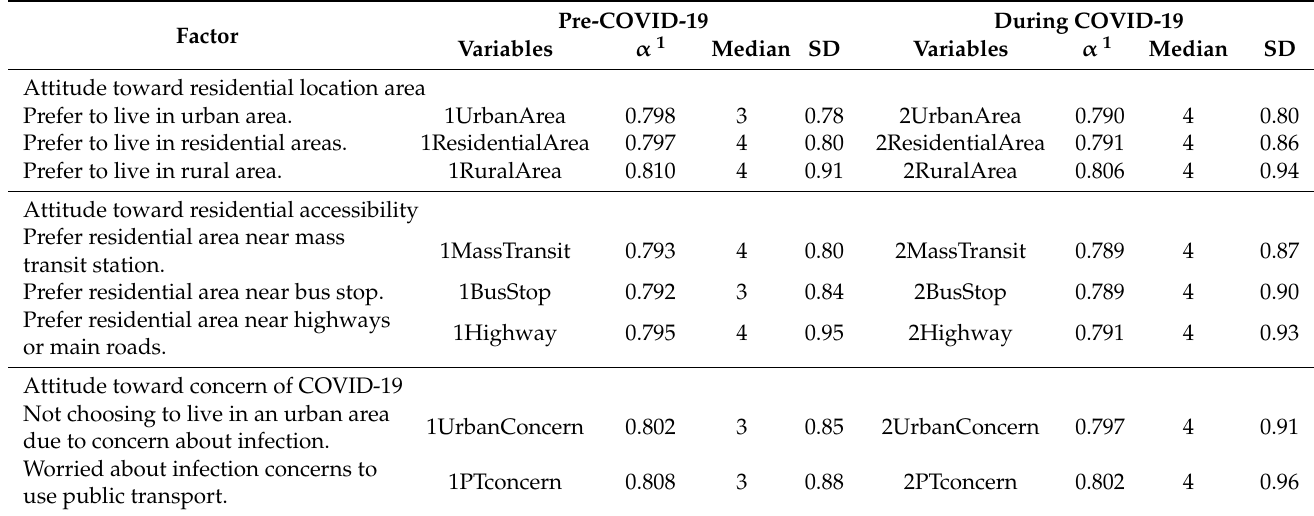
Table 4. Attitude in pre-COVID-19 and during COVID-19